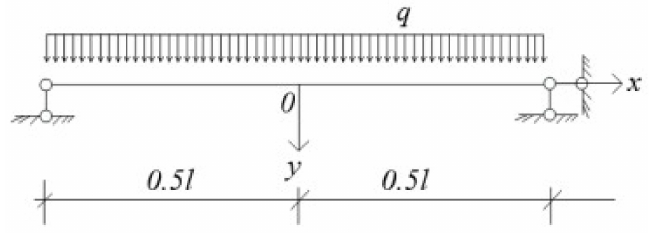
Figure 17. Mechanical model of the wall under distributed